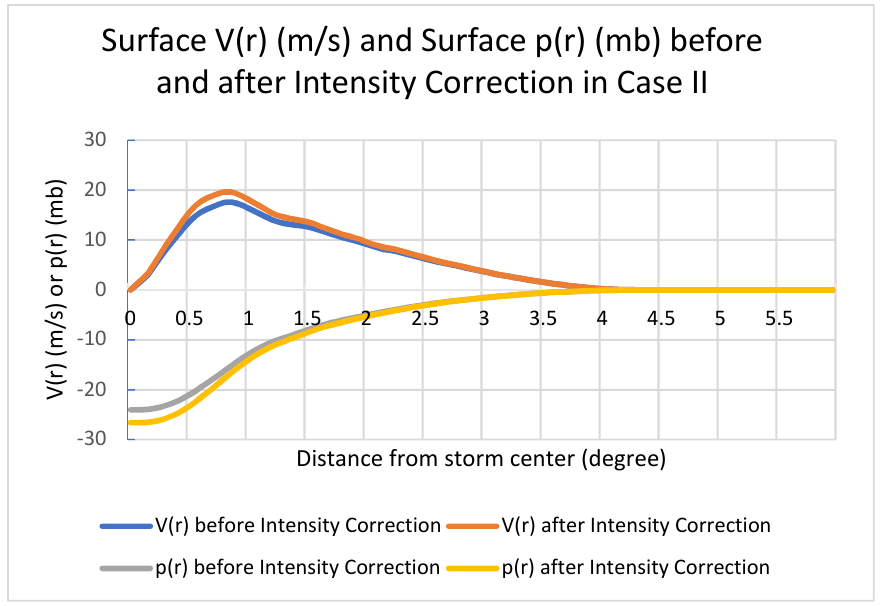
Figure 4. Same as Figure 1 but for storm intensity correction in Case II (maximum surface wind speed increased by ~10%).